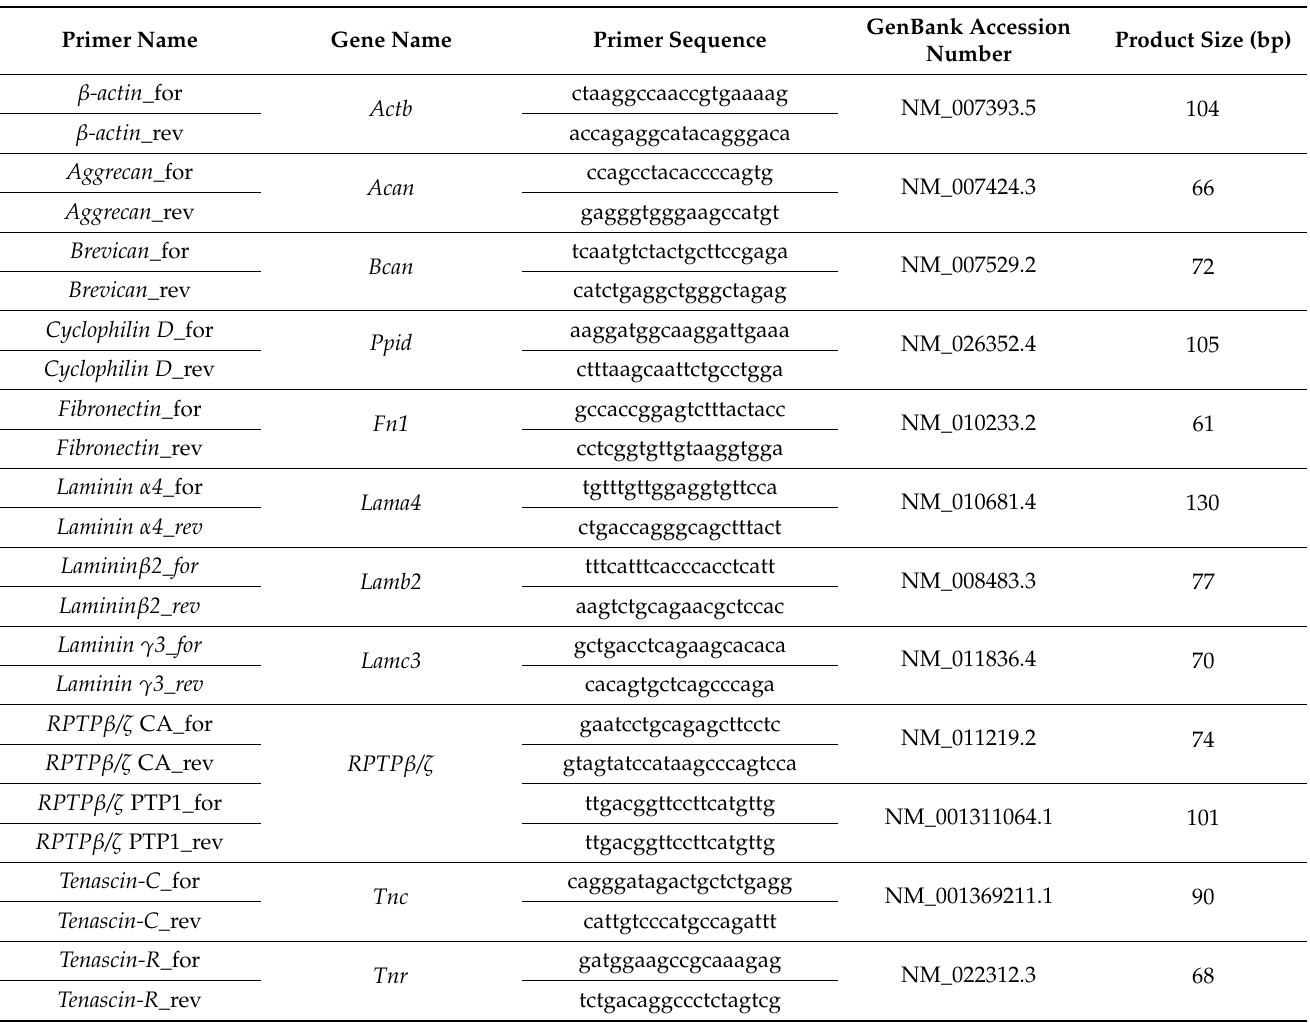
Table 1. List of primer pairs that were used for mRNA analyses in WT and HET retinae and optic nerves via RT-qPCR. To normalize the ECM expression data, the expression of the housekeeping genes β -actin ( Actb ) and cyclophilin D ( Ppid ) was assessed. The table shows the primer names, gene names, primer sequences, GenBank accession numbers, and product sizes. Abbreviations: bp—base pairs, for—forward,